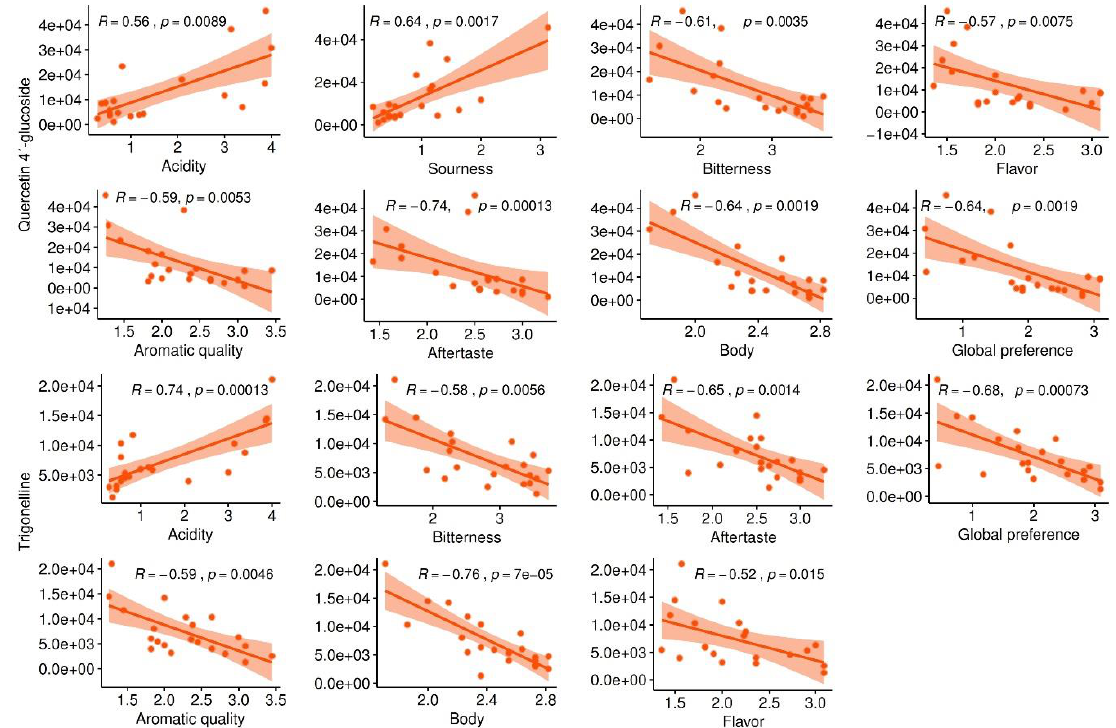
Figure 6. Metabolites of roasted coffee beans linked to multiple sensory traits. The figure shows a significant Pearson correlation (positive and negative) of quercetin 4´glucoside and trigonelline with multiple sensory traits of coffee beverage.